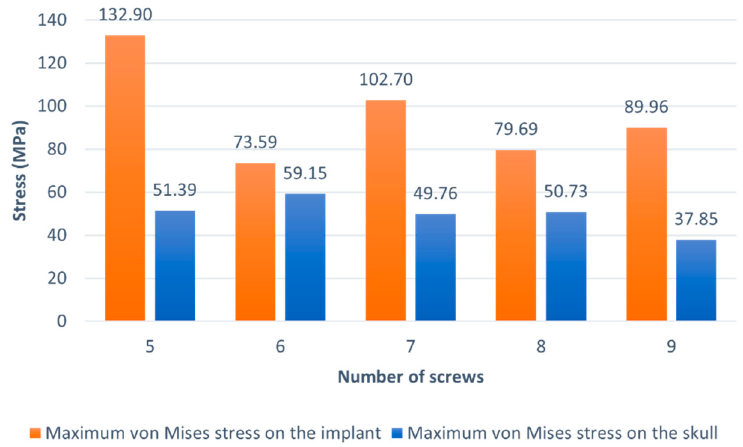
Figure 6. Maximum von Mises stress verified on the implant and the skull for the various models.